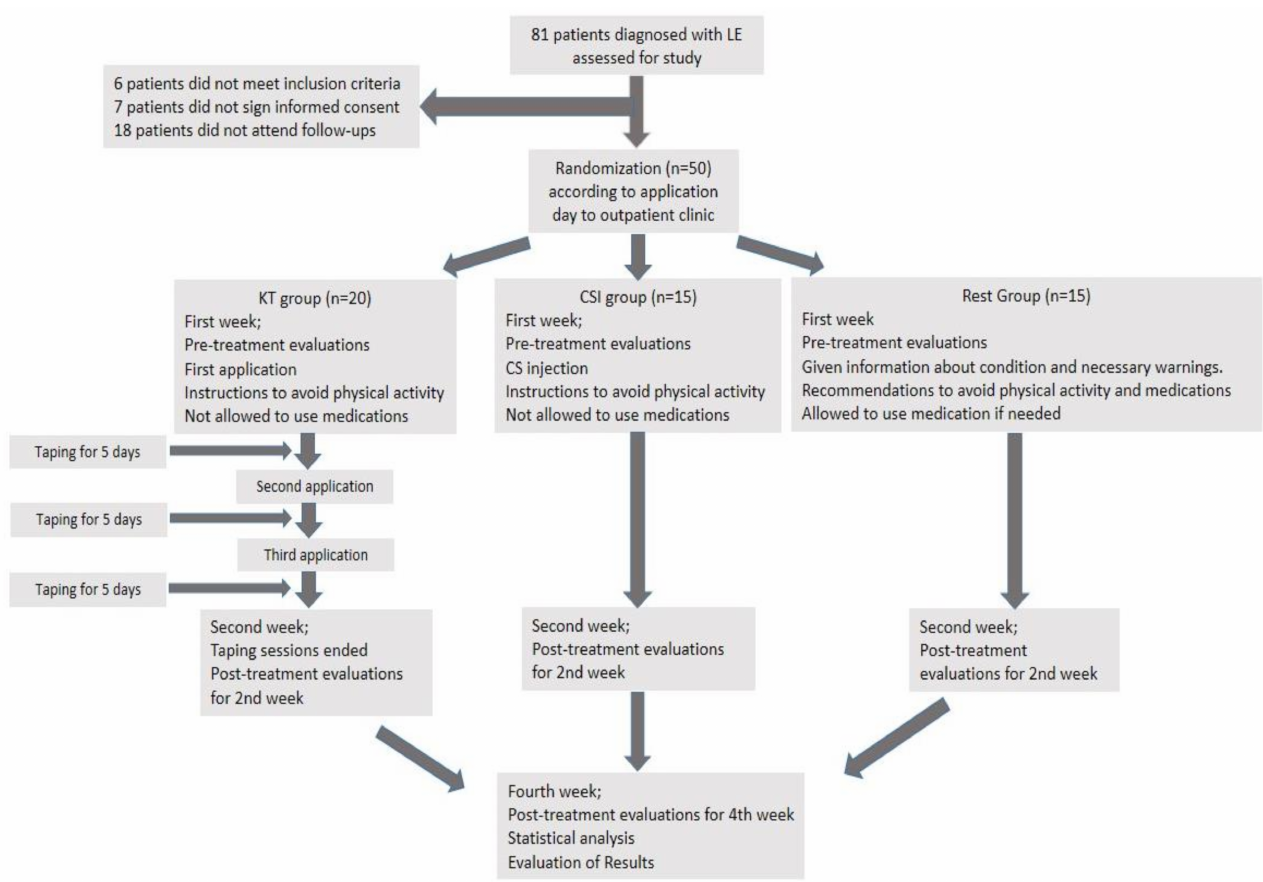
Figure 1. Evaluation of